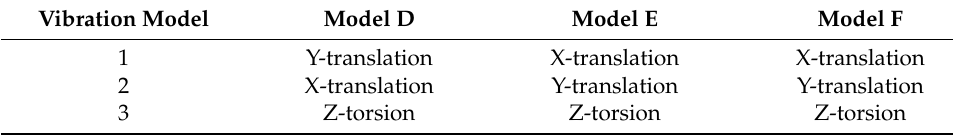
Table 2. The direction of the vibration mode of models. Vibration